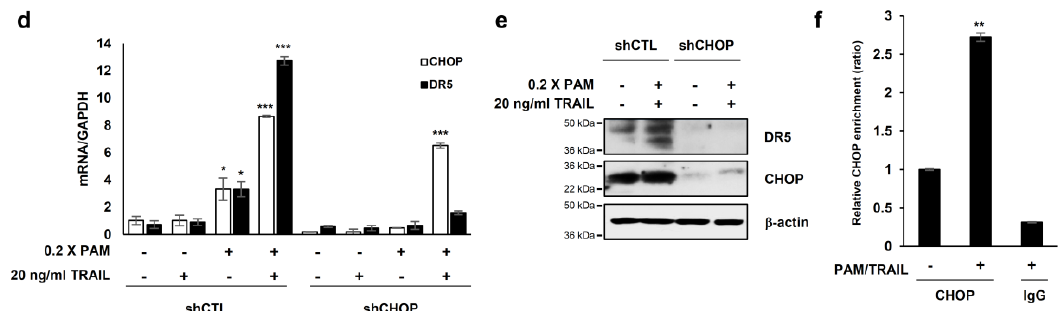
Figure 3. PAM / TRAIL induces DR5 upregulation through CHOP-mediated transcription. ( a ) HeLa cells were treated with 0.2 × PAM alone or PAM / TRAIL. After 24 h, proteins in cell lysates were separated by sodium dodecyl sulfate polyacrylamide gel electrophoresis and immunoblotting with antibodies against CHOP, DR5, and β -actin. ( b ) HeLa cells were treated as described in ( a ). After 24 h, CHOP mRNA levels were determined via qRT-PCR. GAPDH was used as an internal control. ( c ) HeLa cells were co-treated with PAM / TRAIL for 12 h. Afterwards, the culture was replaced with fresh medium, pretreated with or without 5 µ g / mL actinomycin D (Act D) for 30 min, and co-treated with or without PAM / TRAIL for 10 h. mRNA levels of CHOP and DR5 were determined via qPCR. ( d , e ) HeLa cells were transfected with a plasmid expressing either CHOP shRNA (shCHOP) or control shRNA (shCTL). At 24 h after transfection, cells were treated with PAM, TRAIL, or PAM / TRAIL for an additional 24 h. ( d ) Levels of CHOP and DR5 mRNA were determined via qRT-PCR. ( e ) Protein levels of CHOP and DR5 were determined by immunoblot analysis using antibodies against DR5 and CHOP. ( f ) Chromatin immunoprecipitation (ChIP) was performed using anti-CHOP antibody in HeLa cells following PAM / TRAIL treatment for 8 h. The IgG was used to control for antibody specificity. qRT-PCR was carried out using primers surrounding the CHOP binding sites in the DR5 promoter. * p < 0.05, ** p < 0.01, *** p < 0.001.